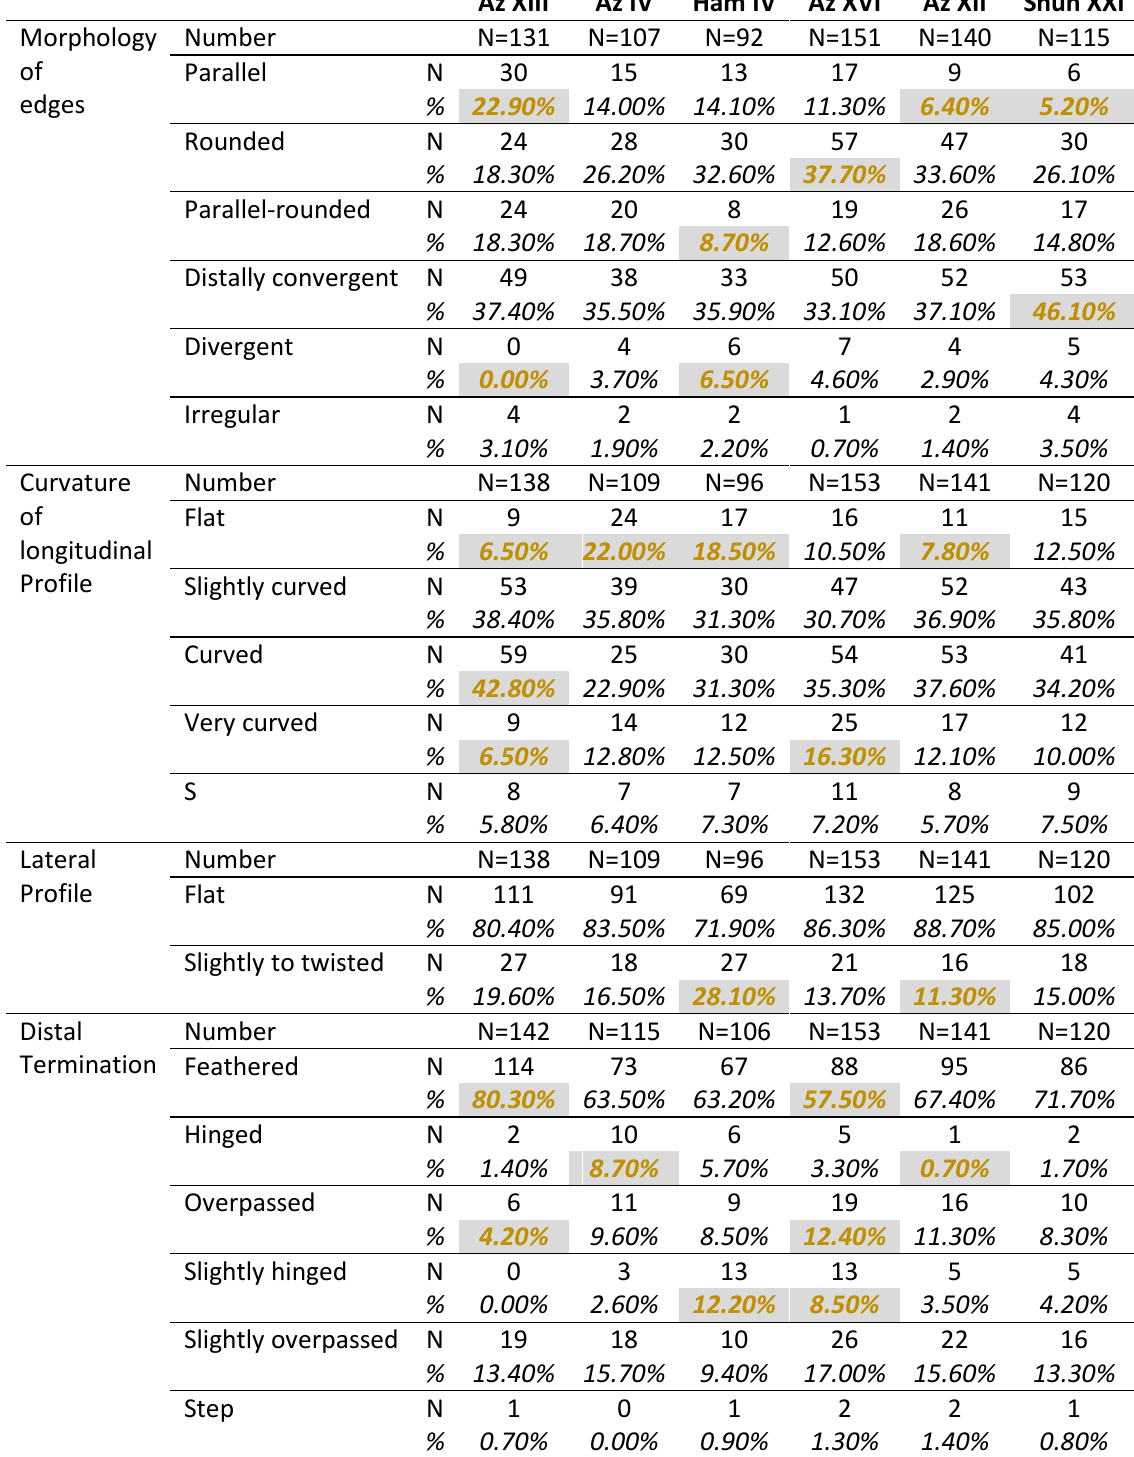
Table 10. Comparisons between sites of main characteristics of elongated blanks. Significant differences are observed between the sites (Chi2 with simulate p-value). Highlighted values which have highest (positive or negative) residuals. Az - Azariq; Shun - Shunera; Ham -